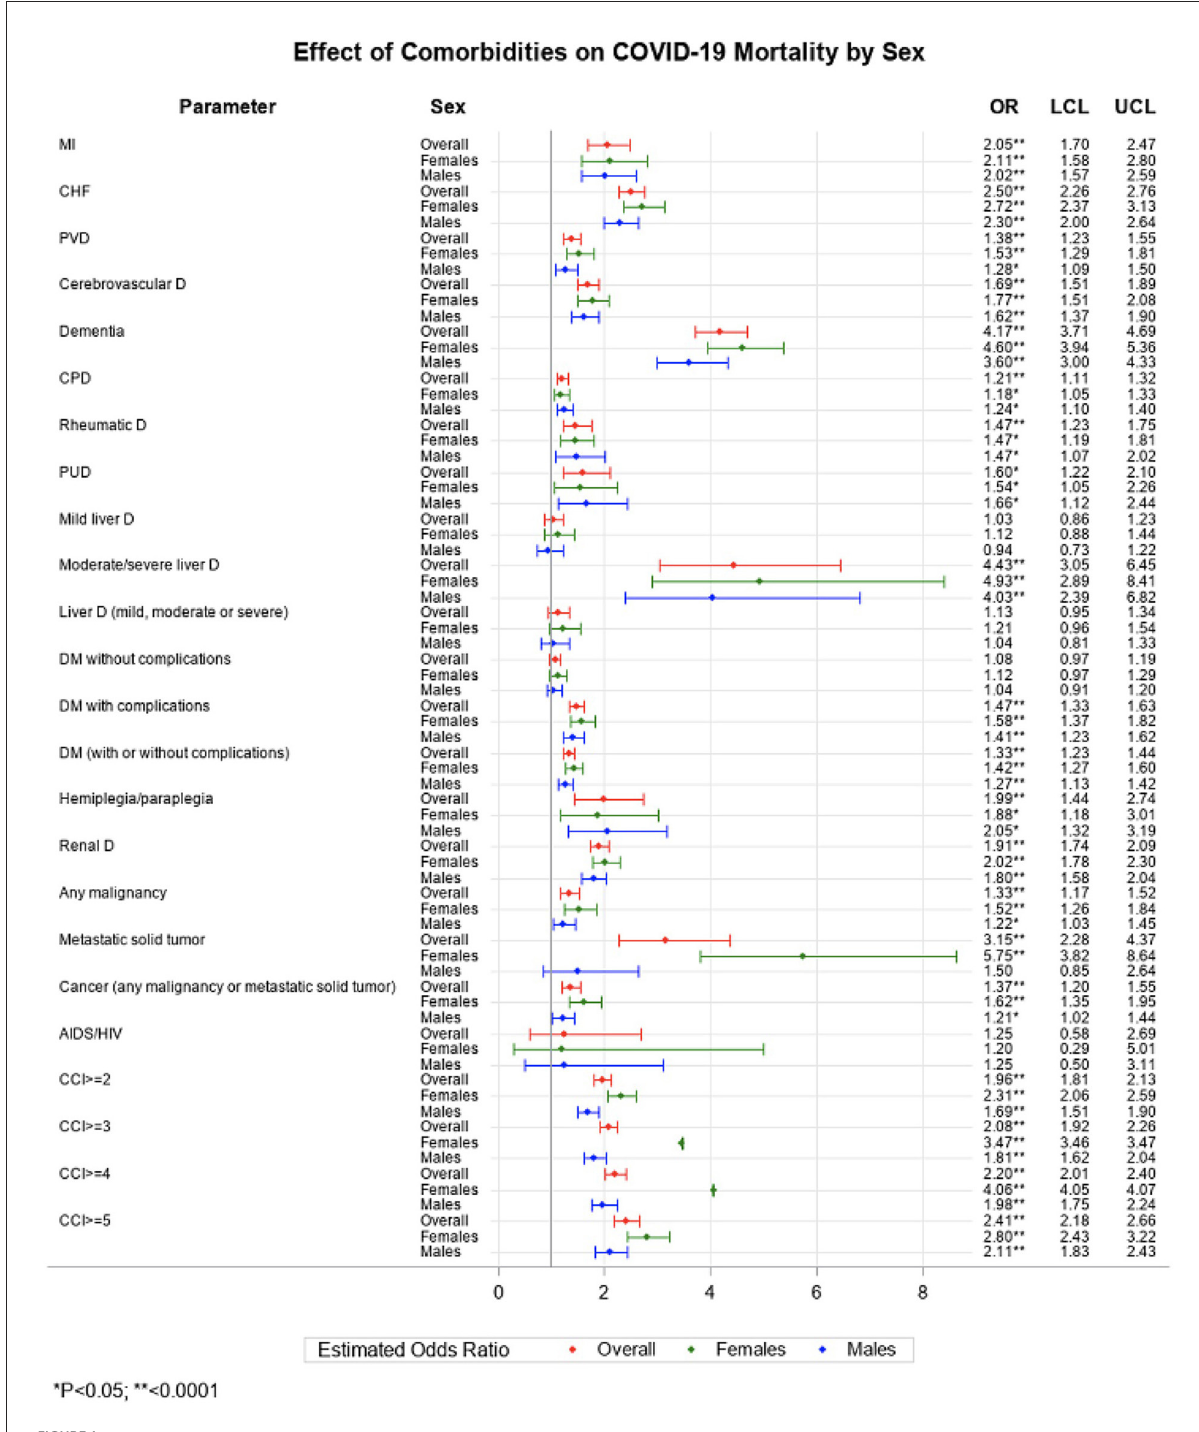
FIGURE1 Odds ratio of comorbidities and mortality in female and male patients with COVID-19.